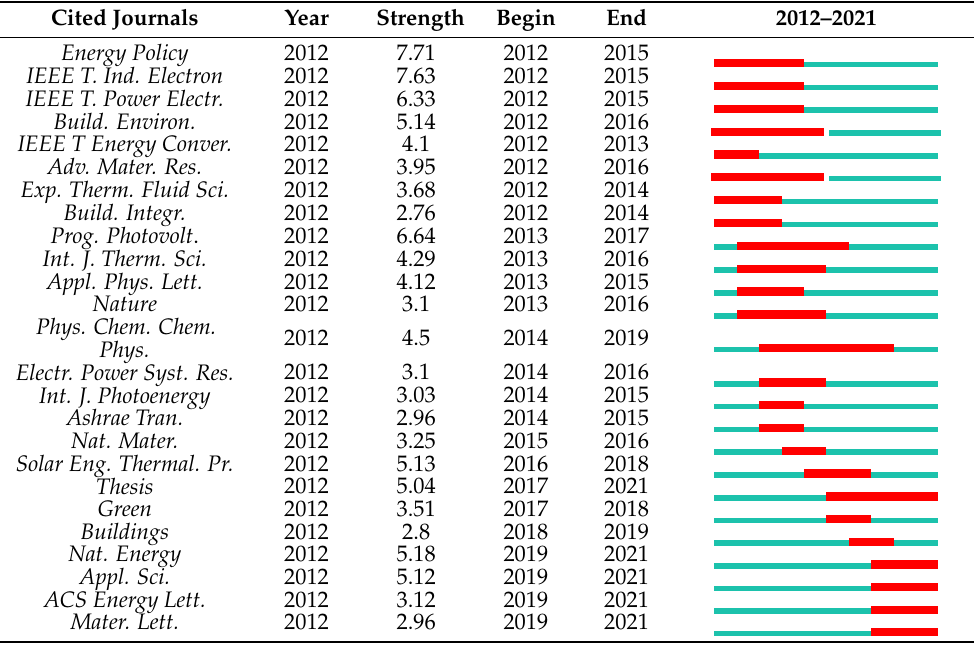
Table 4. The top 25 cited journals with the strongest citation